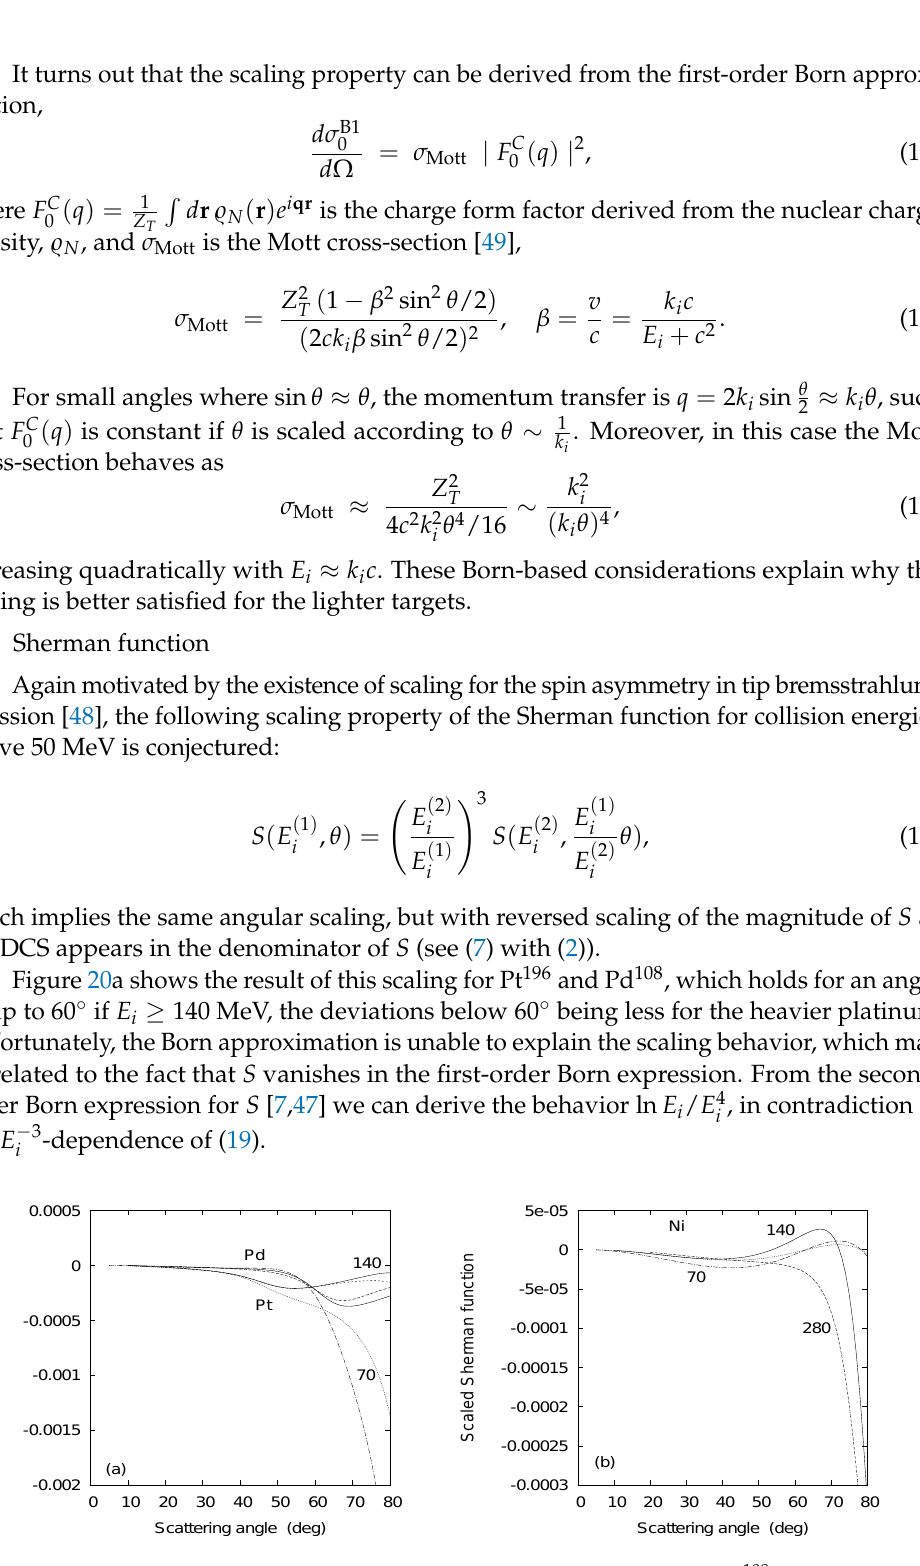
Figure 20. Sherman function from 140 MeV electron impact (——-) on ( a ) Pd 108 (upper line near 40 ◦ ) and Pt 196 (lower line near 40 ◦ ) and ( b ) Ni 58 as function of the scattering angle θ . Included in (a) are the scaled results (to 140 MeV, according to (19)) for 70 MeV impact on Pd 108 ( − · − · − ) and Pt 196 ( · · · · · · ) and for 280 MeV impact on Pd 108 ( − − −− ) and Pt 196 (short-dashed line). Included in ( b ) are the scaled results according to (19) for 70 MeV ( − · − · − ) and 280 MeV ( − − −− ) impact. The scaled results for 70 MeV impact according to Born scaling of the magnitude of S ( · · · · · · ) are included as